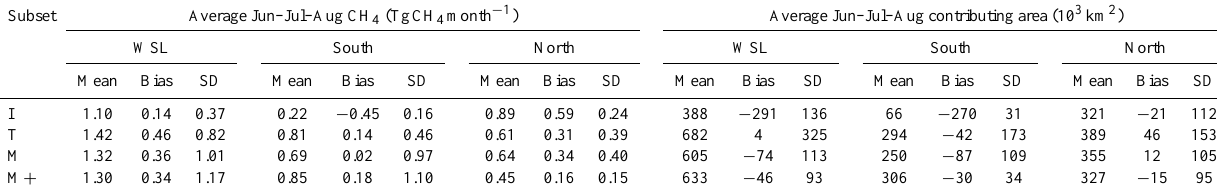
Figure 5. Model estimates of JJA CH 4 emissions (TgCH 4 month − 1 ) and JJA wetland or CH 4 -producing area (10 3 km 2 ): for the entire WSL (top left) and the southern (bottom left) and northern (bottom right) halves, for the period 1993–2004. Lines passing through the origin, with slopes of integer multiples of 1gCH 4 m − 2 month − 1 , allow a comparison of spatial average intensities (CH 4 emissions per unit CH 4 - producing area). Circles denote models that used satellite surface water products alone (corresponding to code S in Table 2) to delineate wetlands. Triangles denote models that used topographic information, with or without surface water products (corresponding to code T in Table 2). Squares denote models that used wetland maps with or without topography or surface water products (corresponding to code M in Table 2). Table 4. Estimates of June–July–August CH 4 emissions from subsets of the participating models, over the entire WSL and its southern ( < 61 ◦ N) and northern halves, for the period 1993–2004. Biases were computed with respect to the Glagolev2011–Peregon2008 estimates.